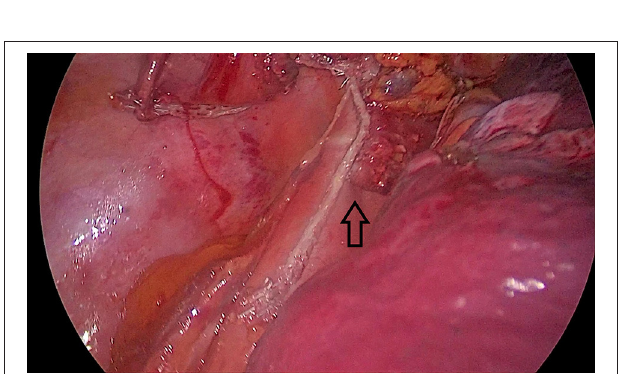
FIGURE 5 | A late fistula (3 weeks after esophagectomy) to lung parenchyma from the stapler line in a 42-year-old female patient. The patient had preoperative chemoradiation and there was no pleural